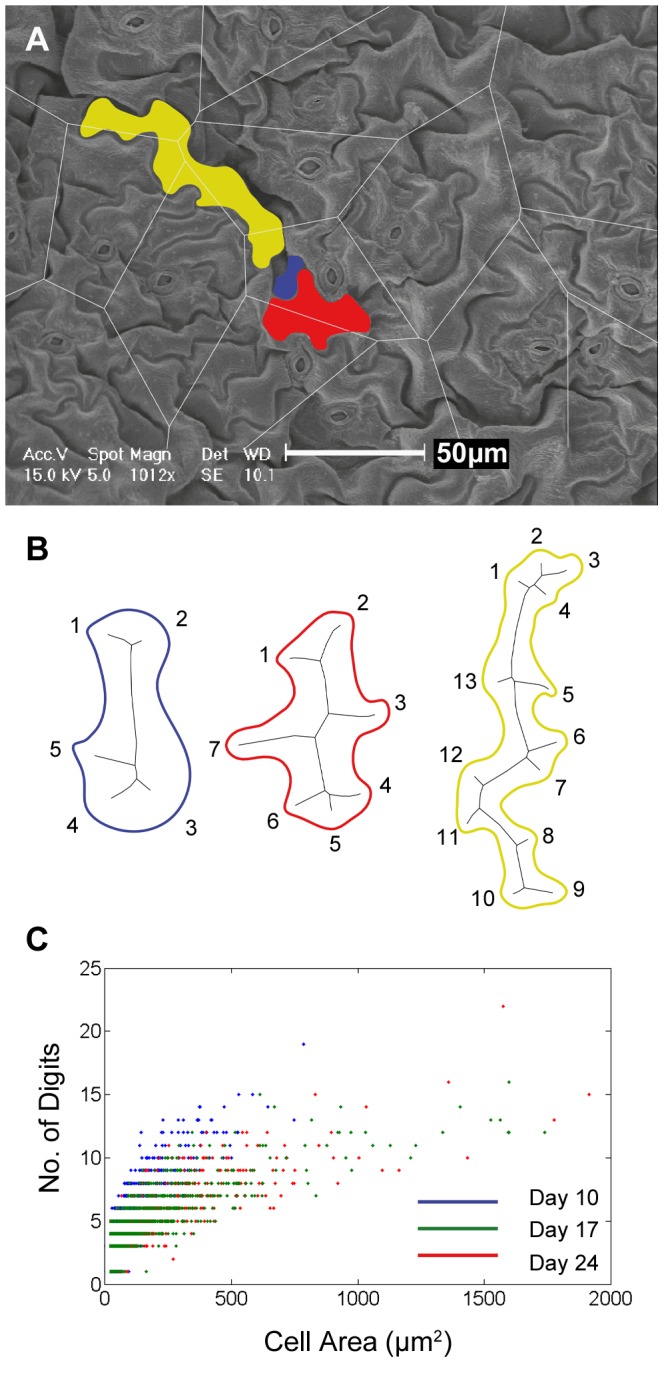
SEM image from day 24 data set: cell shapes and digit numbers per cell area.A SEM image taken from the day 24 series. Shown overlaid (grey lines) is the Voronoi diagram calculated from stomatal centers. Three cells are selected to represent cells of different sizes. B Boundaries of the cells identified in A: blue cell has area of 88 µm2 and 5 digits; red cell has area of 519 µm2 and 7 digits; green cell has area of 1032 µm2 and 13 digits. The ratio of digits per 100 µm2 is 5.6, 1.3 and 1.2 respectively for the blue, red and green cell shown here. For the purposes of shape comparison, the three cells have been re-scaled so that each has roughly the same area. C Scatter plot showing number of digits versus cell area, for the three different age groups. The range of digit numbers is from 1 to 22 and rarely exceeds 15 irrespective of cell size. Also, we see in the younger samples that the digit to area ratio is higher than in the mature samples. Mean no of digits per 100 µm2 for all cells: 6.7 (SD 3.6), 5.6 (SD 3.9) and 5.1 (SD 3.7) for day 10, 17 & 24 respectively. Mean number of digits per 100 µm2 for cells ≥500 µm2: 2.3 (SD 0.3), 1.3 (SD 0.4) and 1.3 (SD 0.4) for day 10, 17 & 24 respectively. Note: the data shown here in C is based on MAT data pruned to remove any external segment <0.55 µm.